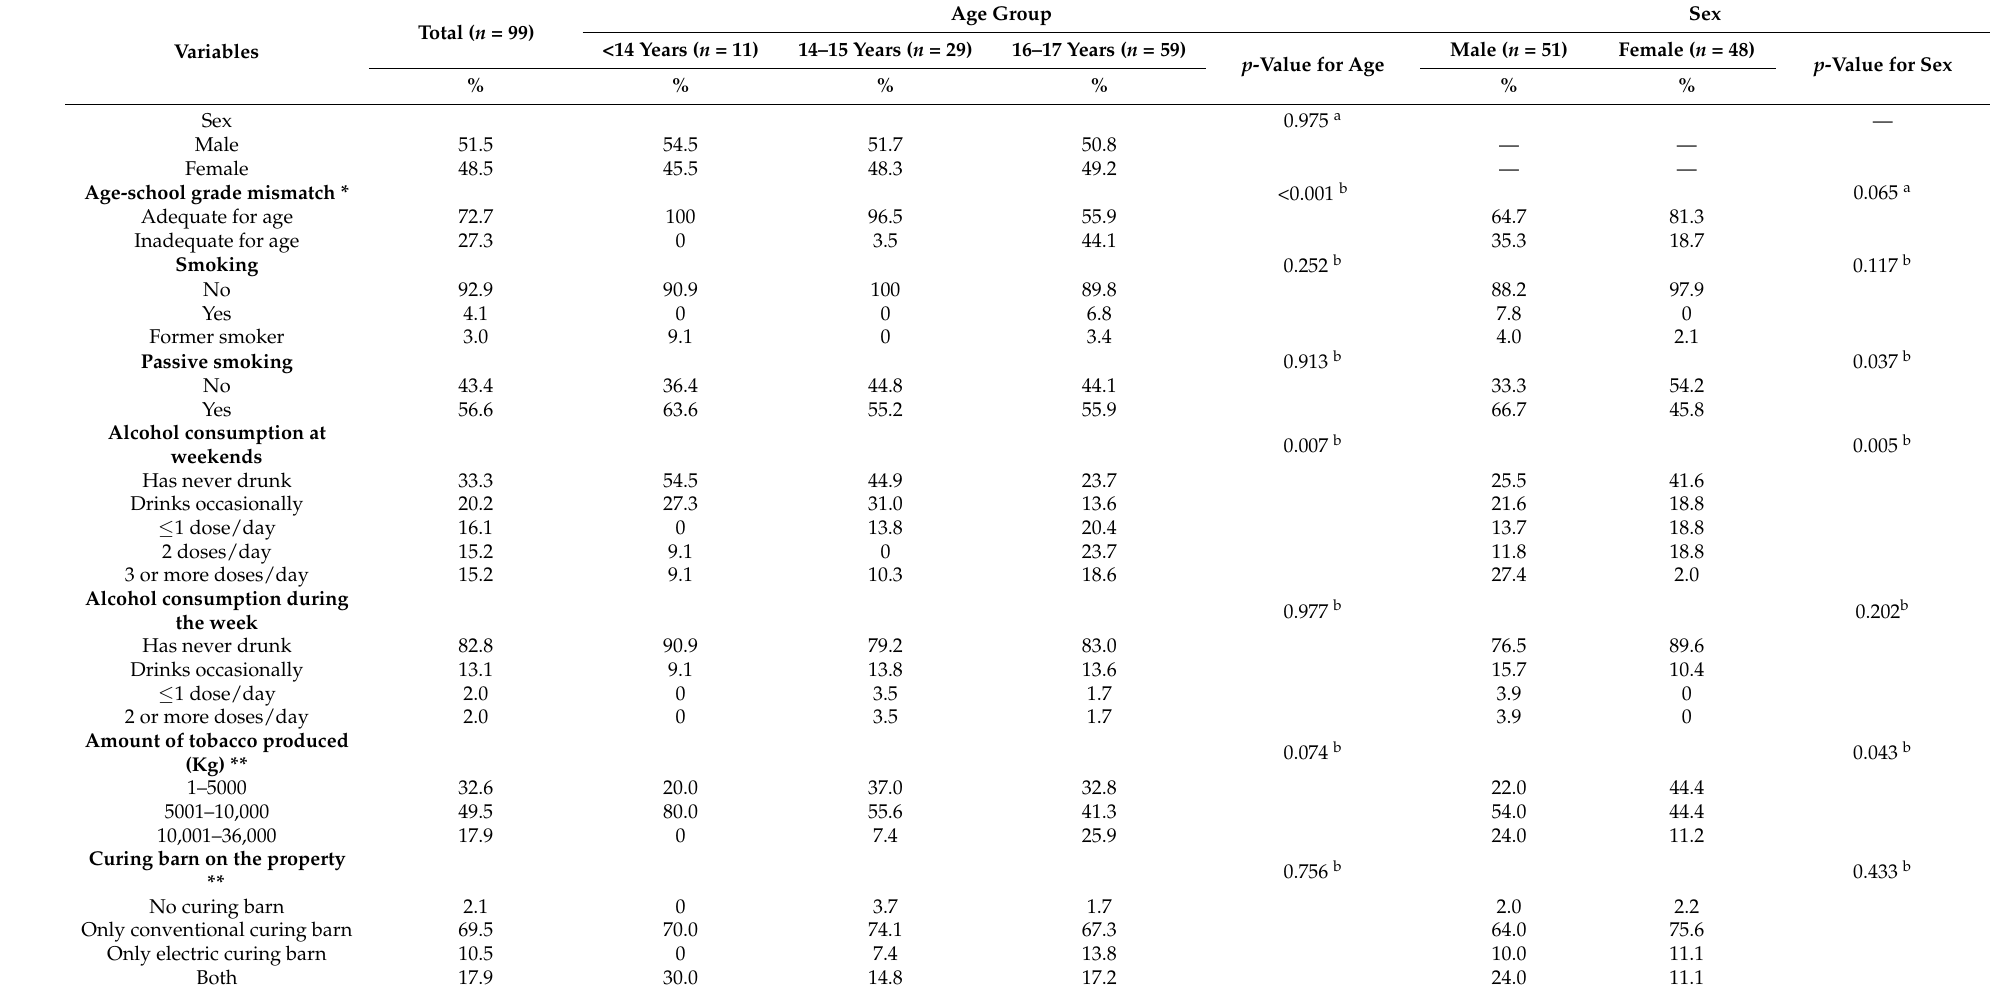
Table 1. Demographic, socioeconomic, and behavioral characterization of tobacco farmers stratified by age and sex. S ã o Lourenço do Sul, Rio Grande do Sul, Brazil, 2011. ( n = 99).